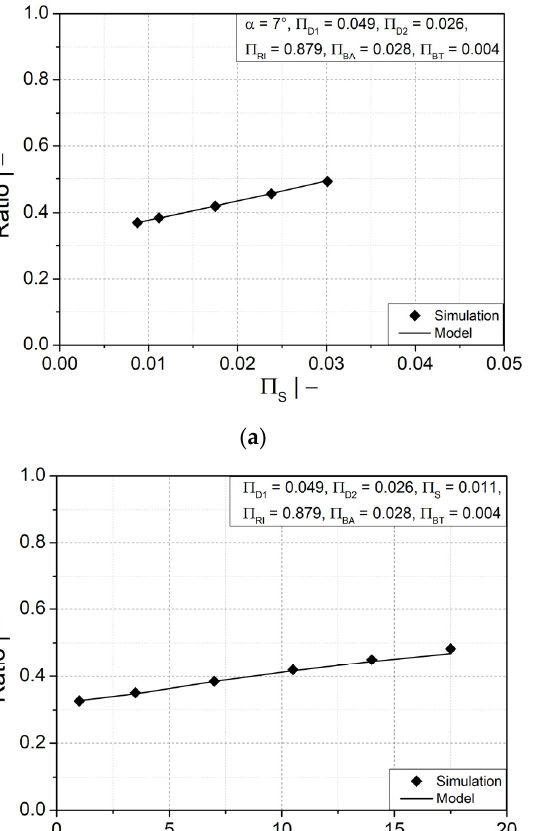
, ( e , f ) dimensionless mold block inner (cid:3250)